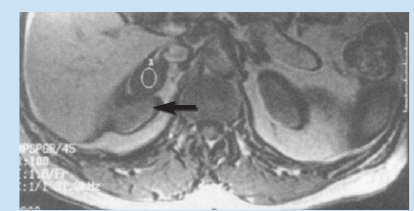
Fig. 5. Chemical shift artefact: bright and dark streaks around the kidneys in an axial gradient- echo opposed-phase image (acknowledgement GE Health